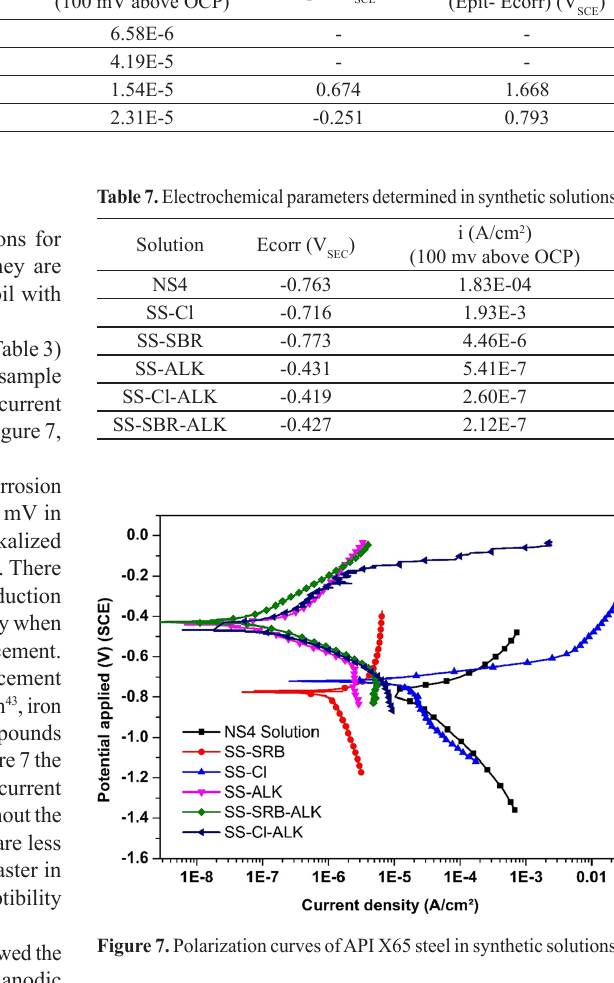
Table 6. Electrochemical parameters determined in aqueous extract of soil 8 with cement and chloride. Soil